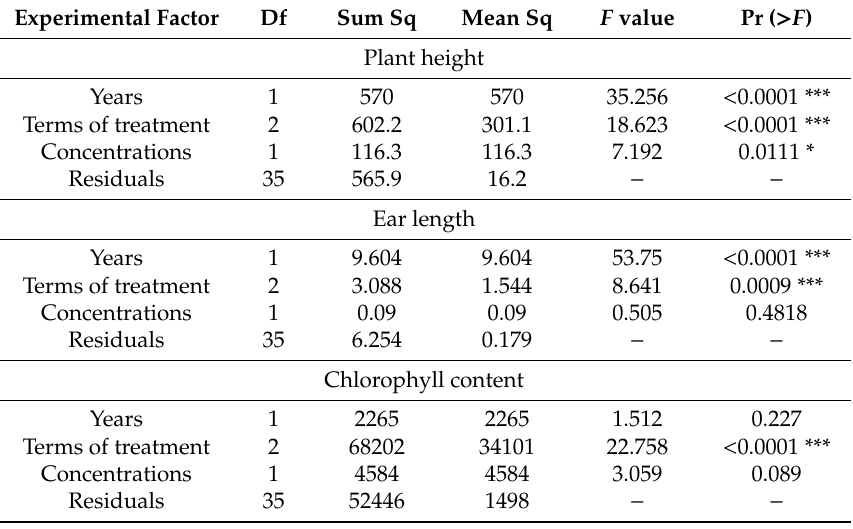
Table 2. ANOVA test for plant height, ear length, chlorophyll content, number of grains per ear, grain density, mass of thousand grains, grain yield, sedimentation index, grain hardness index and protein, gluten and starch content in grains of